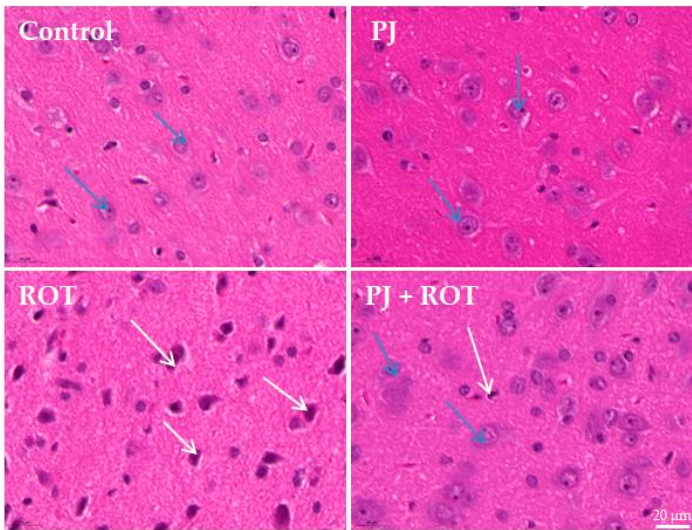
Figure 3. Representative photomicrographs of hematoxylin and eosin (H&E) stained substantia nigra (SN) sections of rats. Control and pomegranate juice alone treated (PJ) rats show normal neurons (blue arrows). Rotenone (ROT) administration caused prominent degeneration of neurons (white arrows). A rat treated with pomegranate juice and rotenone shows normal neurons (blue arrows) and a few cells with signs of degeneration (white arrows). Original magnification ×400; Scale bar—20 μ m.